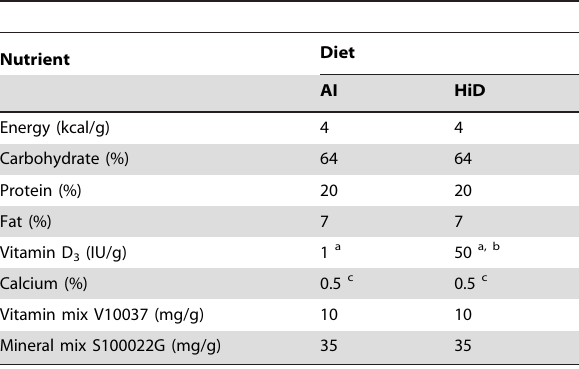
Table 1. Nutrient content of the adequate intake (AI) and high (HiD) vitamin D 3